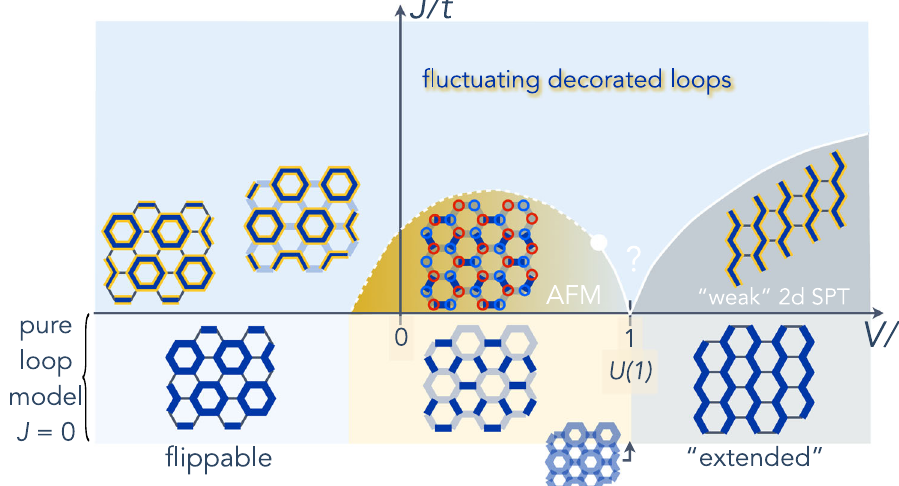
Fig. 4 Phase diagram in 2 d in the V / t − J / t plane ( t = 12 υ 3 / ζ 2 ), for J ≥ 0 and ζ > 0. The phase diagram of the pure plain loop model is shown below the horizontal axis. In the small J / t region, the simplest situation of a single “ intermediate ” antiferromagnetic (AFM) phase is shown (a nematic valence bond solid-phase and multiple-phase transitions may also appear for some parameters, see “ Methods ” and Fig. 5). In the intermediate J / t region, the location and nature of the phase transitions are speculative. The solid and dashed white lines and the white dot represent putative second and fi rst-order transitions, and critical end point, respectively. Thick blue lines represent the strength of orbital overlaps (darker blue means larger overlap), yellow contours Haldane chains and red and blue circles S z = 1 and S z = − 1 spins. As indicated in the text, SPT stands for symmetry-protected topological phase.